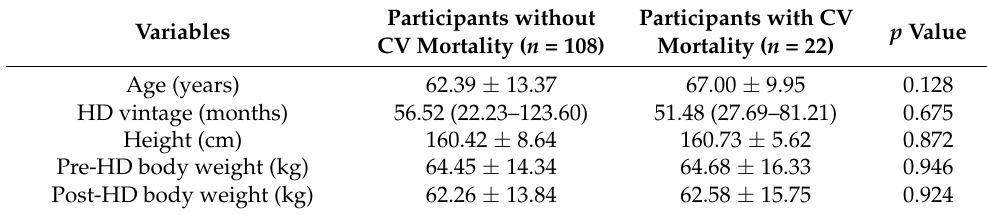
Table 4. Clinical variables of the 130 hemodialysis patients with or without cardiovascular